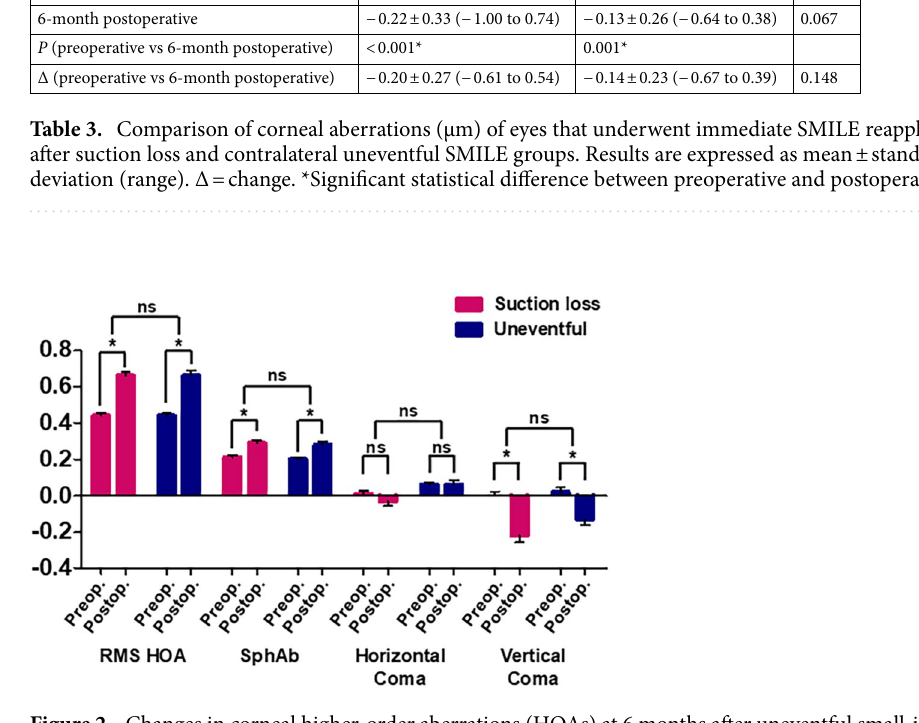
stage at the time of suction loss. In this study, suction loss occurred during the posterior lenticule surface cut in 53% of eyes and during the cap cut in 47% of eyes. The planned cap thickness ranged from 90 to 135 μm. According to a study by Reinstein et al., treatment options for suction loss during the posterior lenticule surface cut include thinner cap SMILE, thin-flap LASIK, and Re-SMILE 15 . Treatment options for suction loss during the cap cut include continuation of SMILE, re-initiation of the cap cut, and thin-flap LASIK. The treatment options are recommended according to the type of patient eye movement, sustained centration, tracked interface, and planned thickness of the cap. In addition, Liu et al. considered the progression rate of the posterior lenticule surface cut procedure before suction loss when selecting a treatment option 18 . According to Liu et al., LASIK should be recommended when the posterior lenticule surface cut procedure has progressed by > 10% to avoid an irregular posterior lenticule surface and stromal-free slivers. In Liu et al.’s study, the posterior lenticule surface